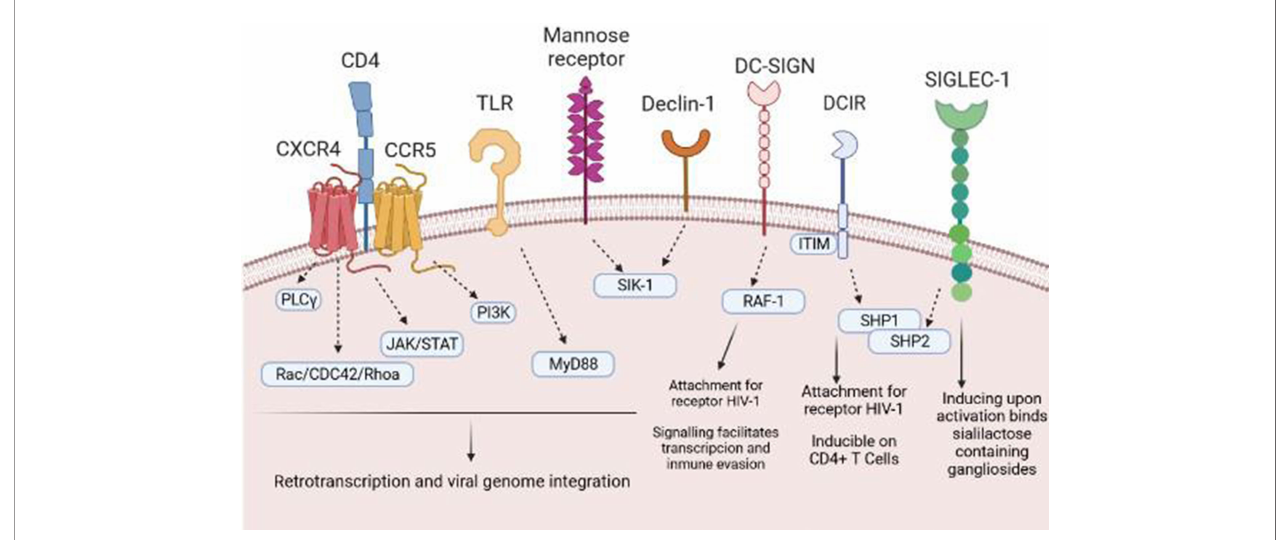
FIGURE 1 | Receptors and pathways involved in the entry of HIV-1 into DCs. HIV-1 binds to several different DC surface receptors, determining the fate of the virus. Generally, HIV-1 is introduced to DCs through endocytosis after binding to DC-SIGN or other receptors, such as Declin-1 or Siglec-1. Binding to these receptors generates a series of intracellular signals that allow transinfection or immunological recognition and the consequent activation of T